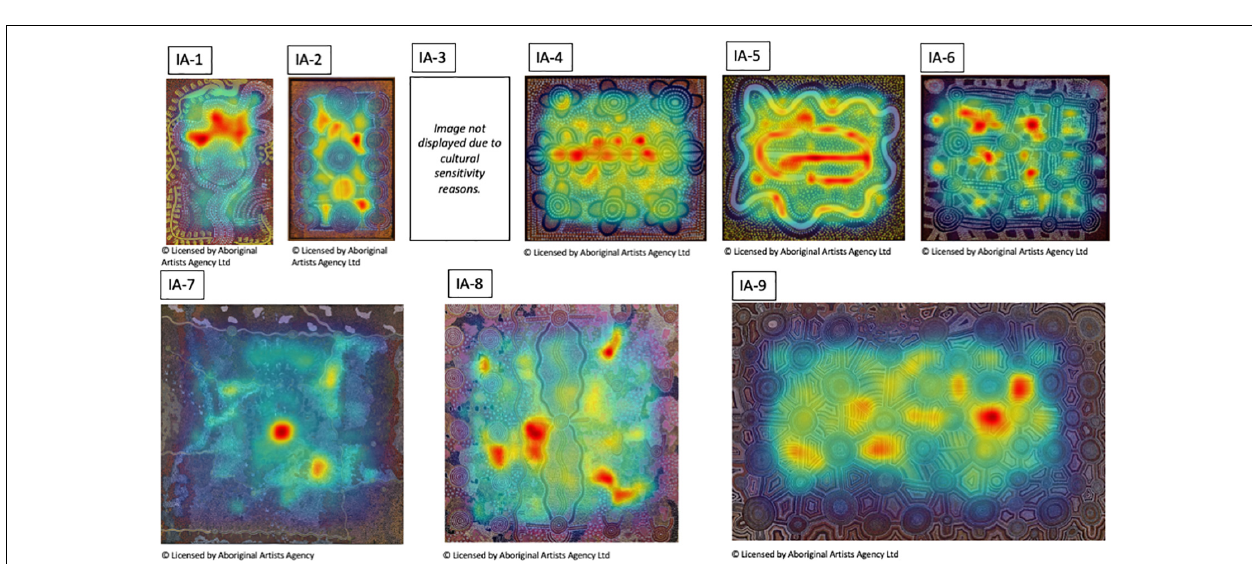
FIGURE 12 | Graph-based Visual Saliency maps (Harel et al., 2007) for the non-Indigenous Australian paintings.